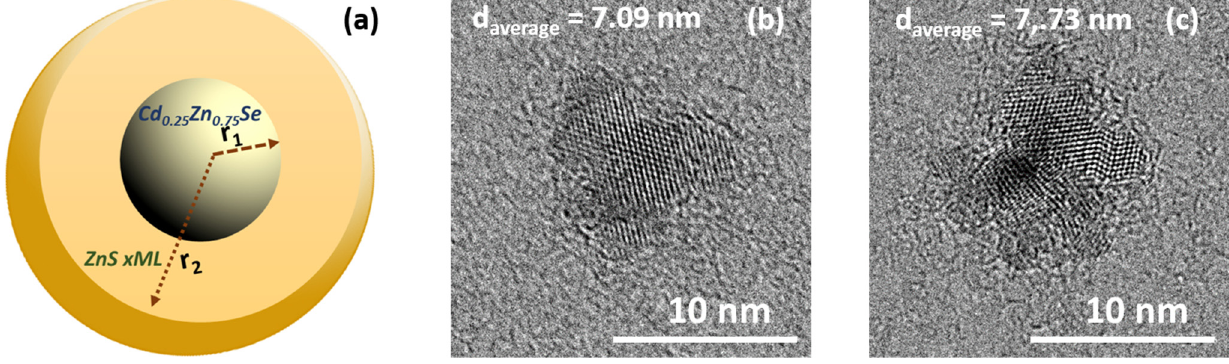
Figure 4. Theoretical model of core/shell quantum dot ( a ), HRTEM images of Cd 0 . 25 Zn 0 . 75 Se/ZnS 4 MLs ( b ), and Cd 0 . 25 Zn 0 . 75 Se/ZnS 5 MLs ( c ).